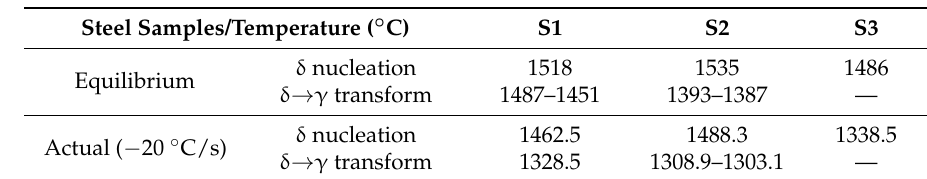
Table 2. Comparison of temperature of nucleation and δ – γ transformation between theoretical and experimental tests.